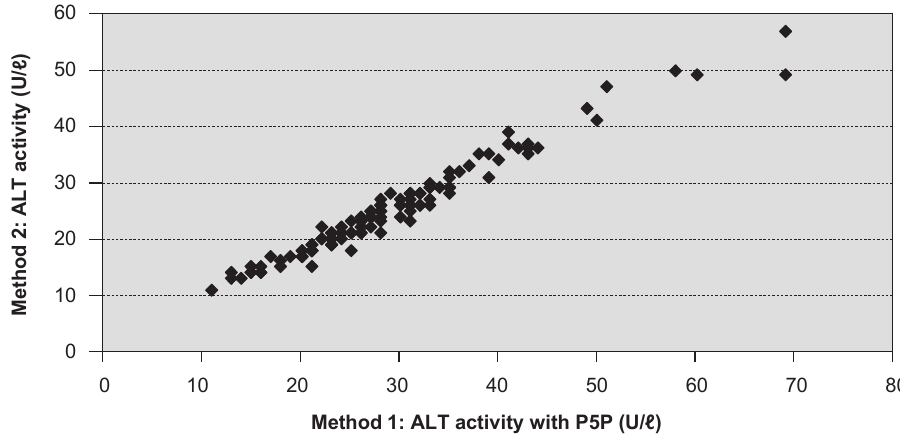
FIG. 1 Correlation of ALT measurements with P5P (Method 1) and ALT measurements without P5P (Method 2) in the control